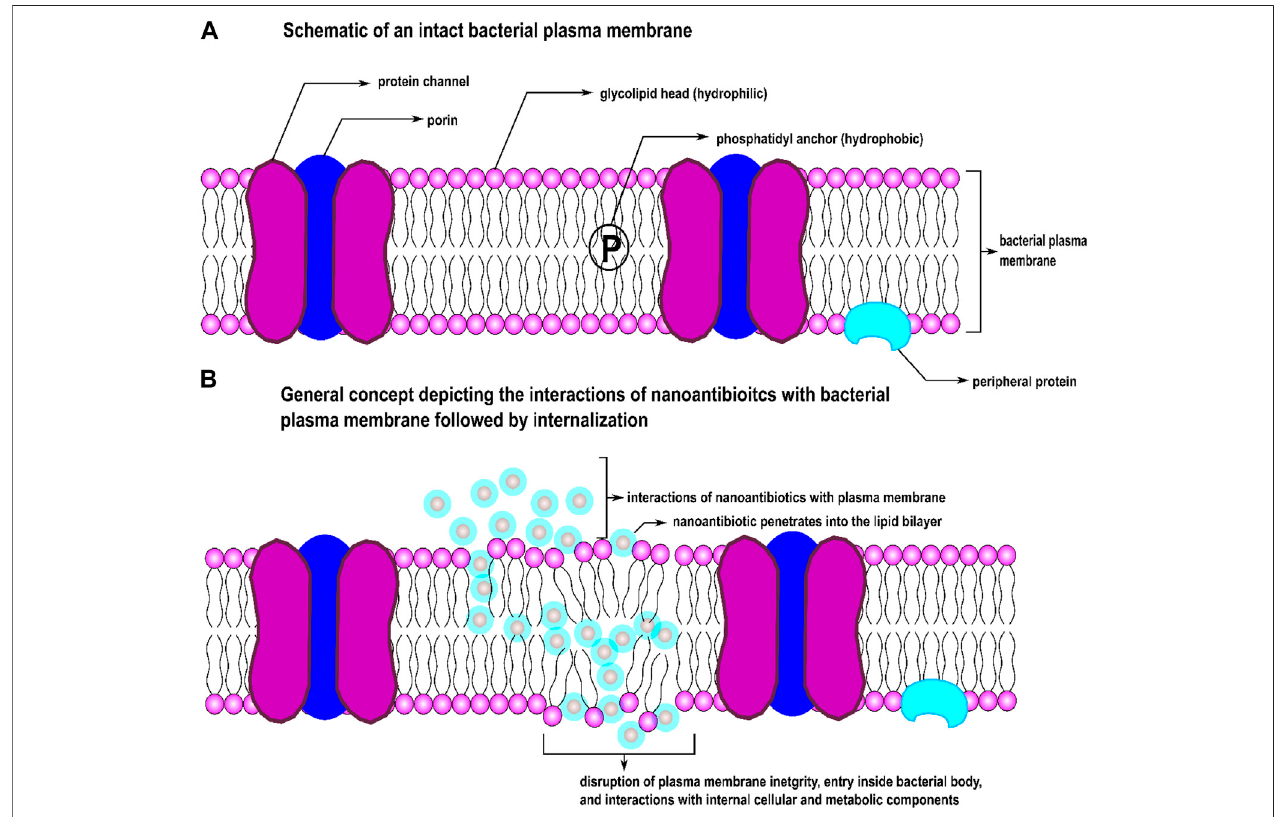
FIGURE 1 | Schematic of (A) an intact bacterial cell membrane and (B) effect of nAbts on the integrity of a bacterial cell membrane.